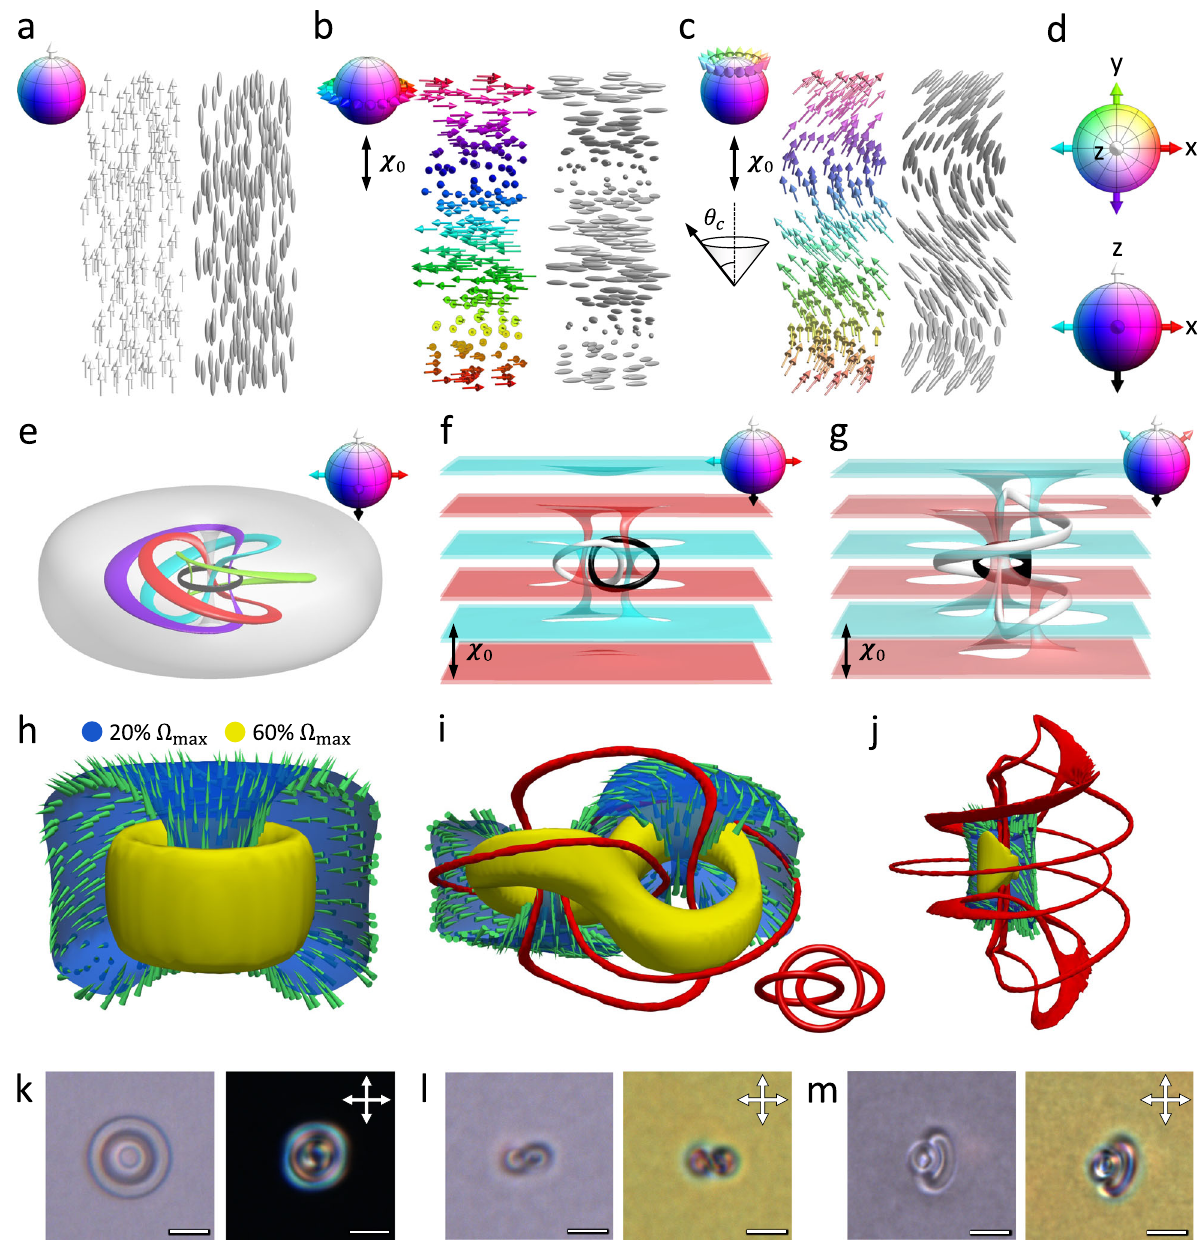
Fig. 1 3D Hopf solitons in topologically trivial backgrounds. a – d Schematics of n ð r Þ backgrounds in uniform ( a ), helical ( b ), and conical ( c ) states represented by arrows for vector fi elds and ellipsoids for nonpolar director fi elds, respectively. The conical state is at a cone angle θ c with respect to the helical axis χ . Vectors are colored based on their orientations as shown in the order-parameter sphere in insets and in ( d ). e – g Preimages of vector 0 orientations (shown in insets as arrows in the order-parameter sphere) of Hopf solitons stabilized in a uniform ( e ), helical ( f ), and conical ( g ) background. h – j Visualizations of the skyrmion number density Ω and vortex lines of stabilized Hopf solitons in different backgrounds corresponding to e – g , respectively. The inset in i shows vortex line in the heliknoton can form mutually linked rings 17 . k – m Hopf solitons observed in chiral LCs using bright- fi eld (left panels) and POMs (right panels) in a uniform ( k ), helical ( l ), and conical ( m ) background, respectively. The directions of cross polarizers are shown in the insets and scale bars are 5 µ